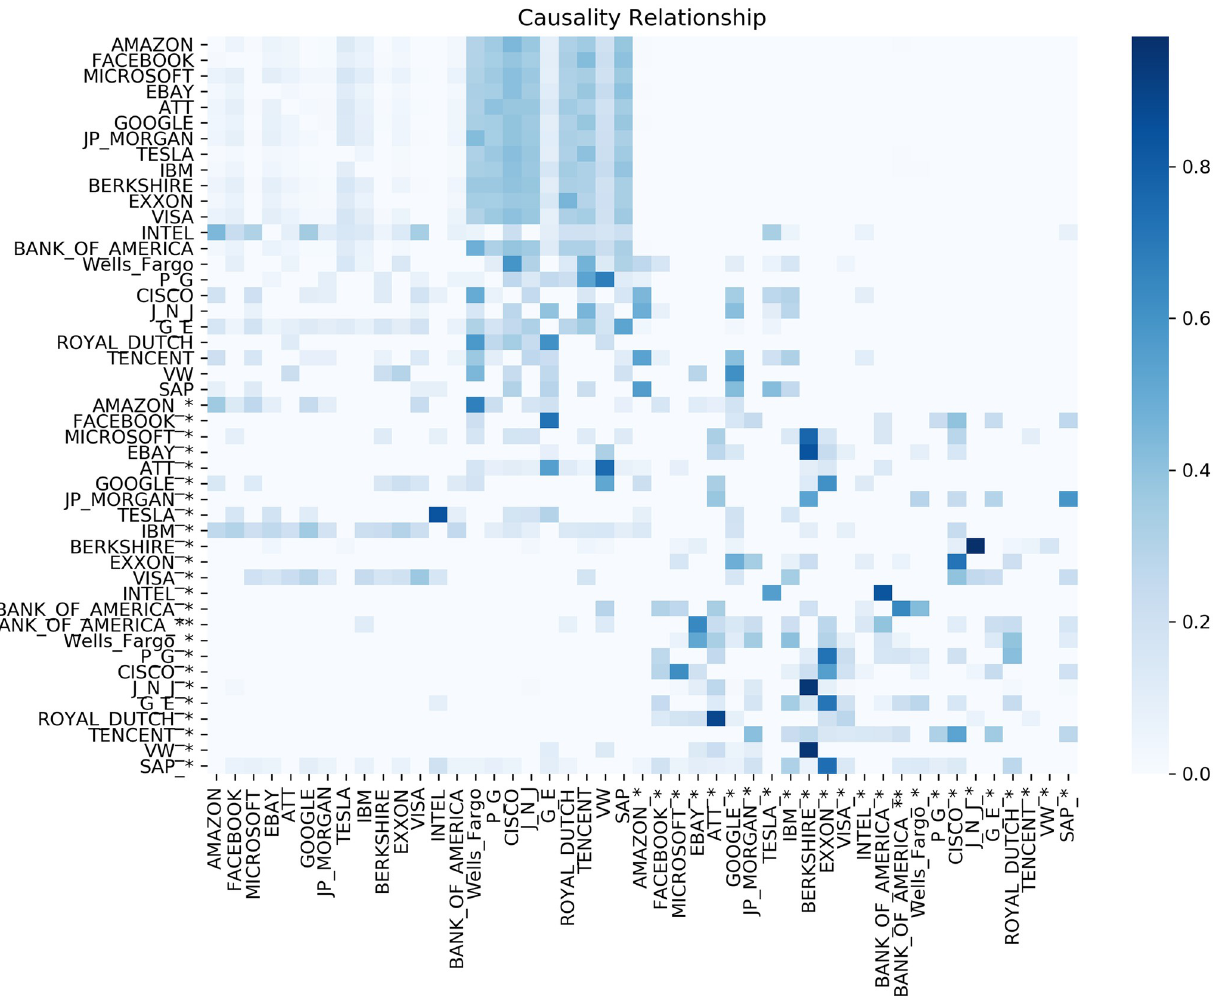
Fig 4. Granger Causality relationship with a lag of 3 and p-value p �